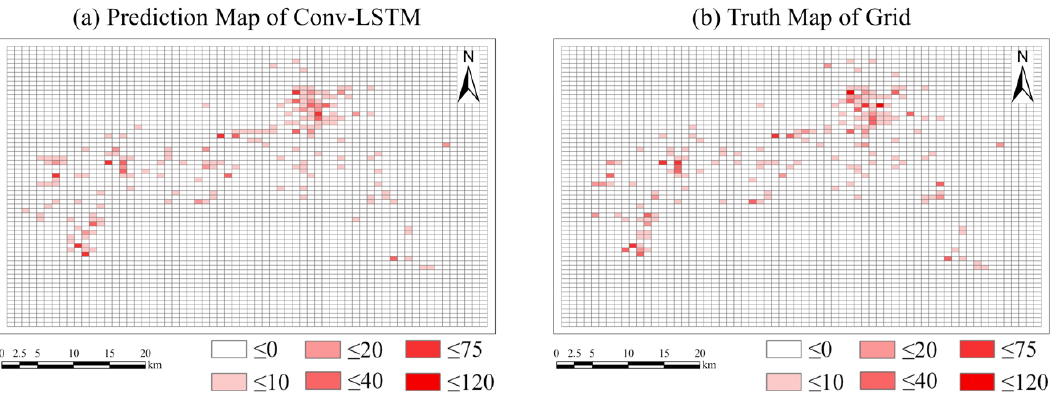
Figure 14. Comparison between the predicted result using Conv-LSTM and the truth. ( a ) Predicted result of traffic violations using Conv-LSTM. ( b ) Truth values of traffic violations divided by regular space